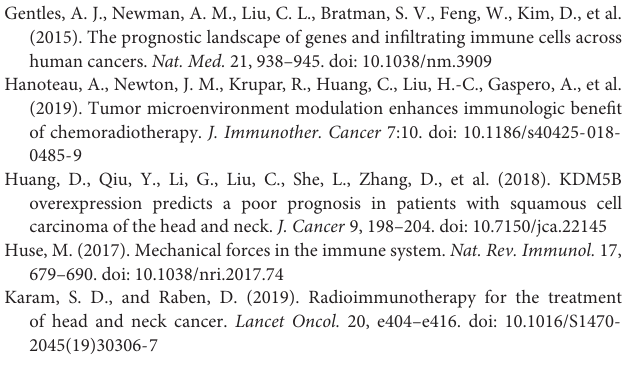
Supplementary Figure 1 | Any other immune cells enriched of IGRPs signature in